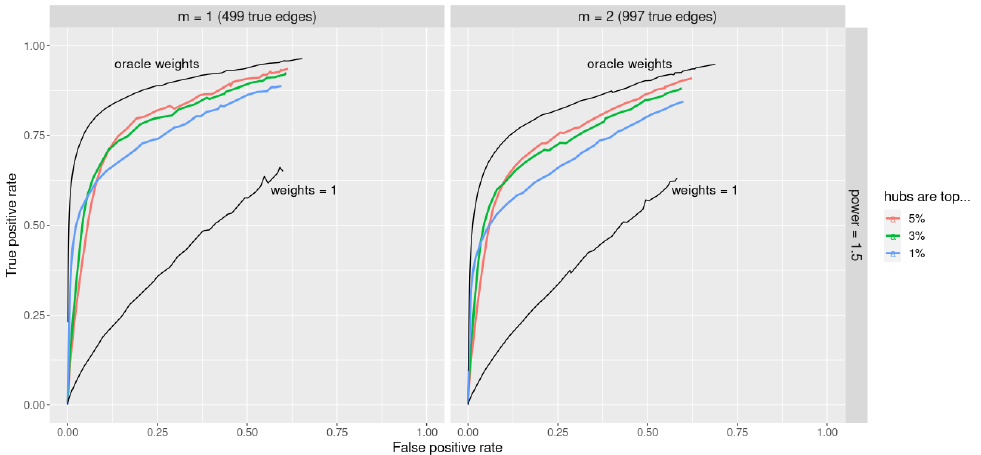
Figure 5. ROC curves for jewel 2.0 method applied to K = 3 datasets of the size p = 500, n k = 100. Parameter power = 1.5. The upper black lines demonstrate the excellent performance obtained with the oracle weights compared to the lower black lines that correspond to W ( k ) = 1 (i.e., the standard unweighted approach). Performance with the simple procedure that assigns weights as hub/non-hub using prior information is given in different colors depending on the percentages of nodes declared hubs. Left panel : performance for m = 1, i.e., 499 edges. Right panel : performance for m = 2, i.e., 997